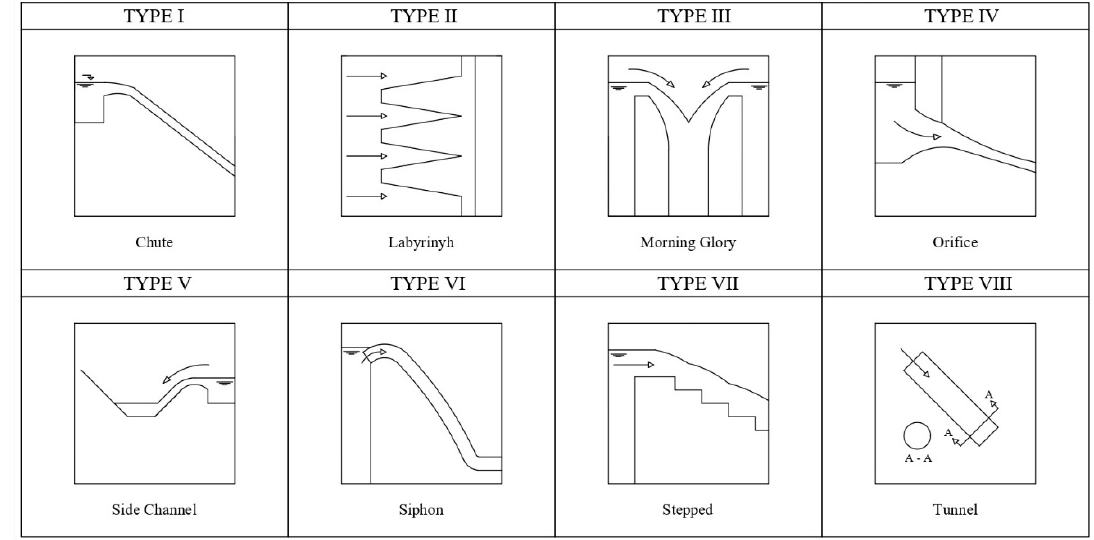
Figure 2. Overview of several spillway types. Adapted from : [47].